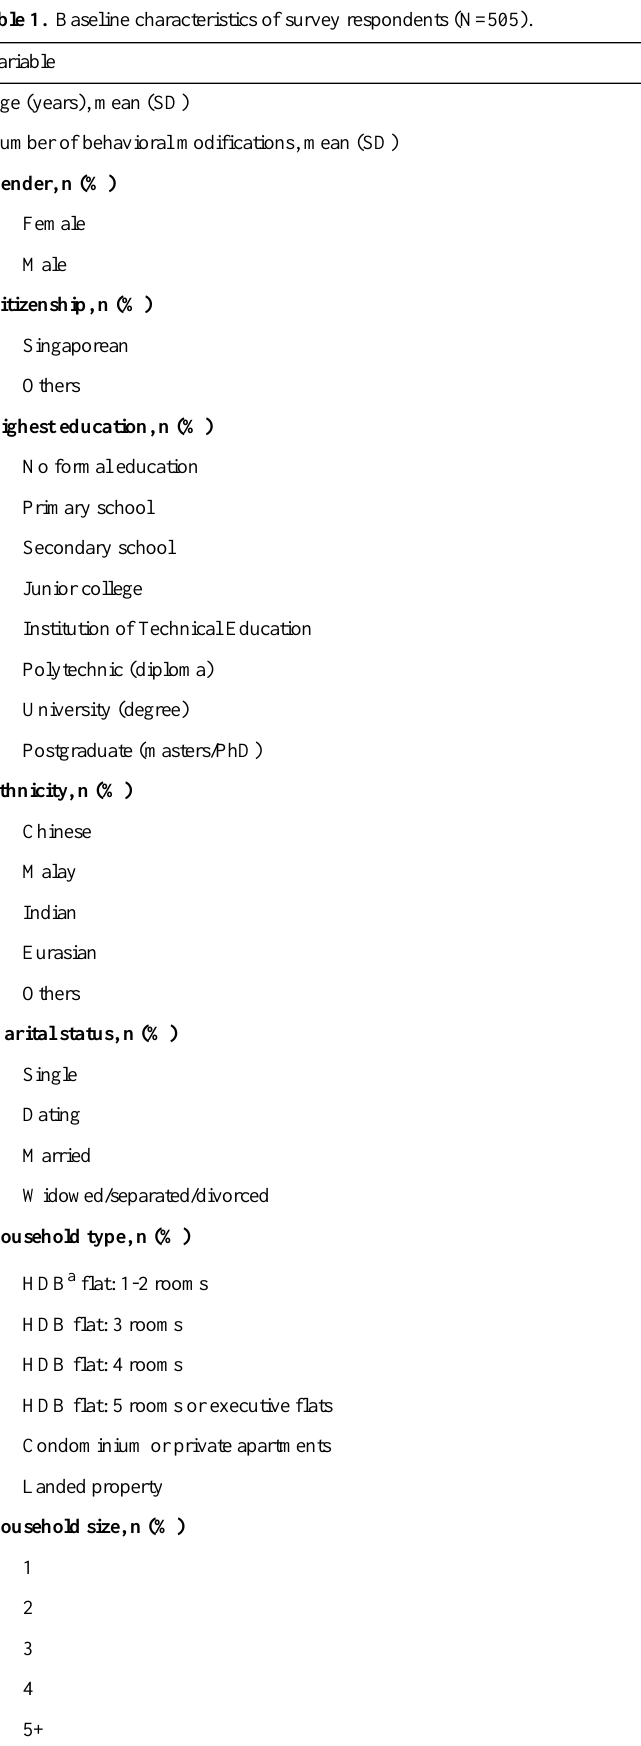
Table 1. Baseline characteristics of survey respondents